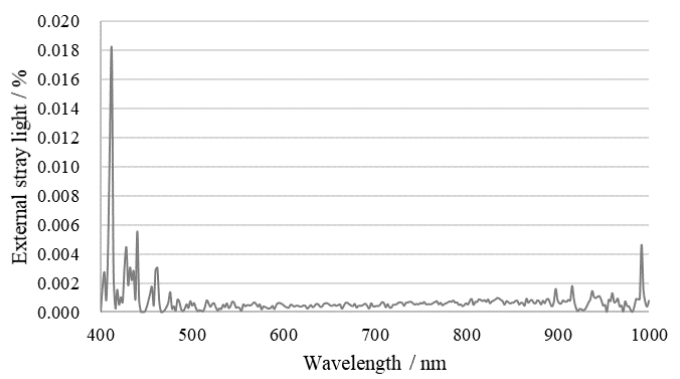
Figure A2. Stray light during calibration as a percentage of the measured signal.